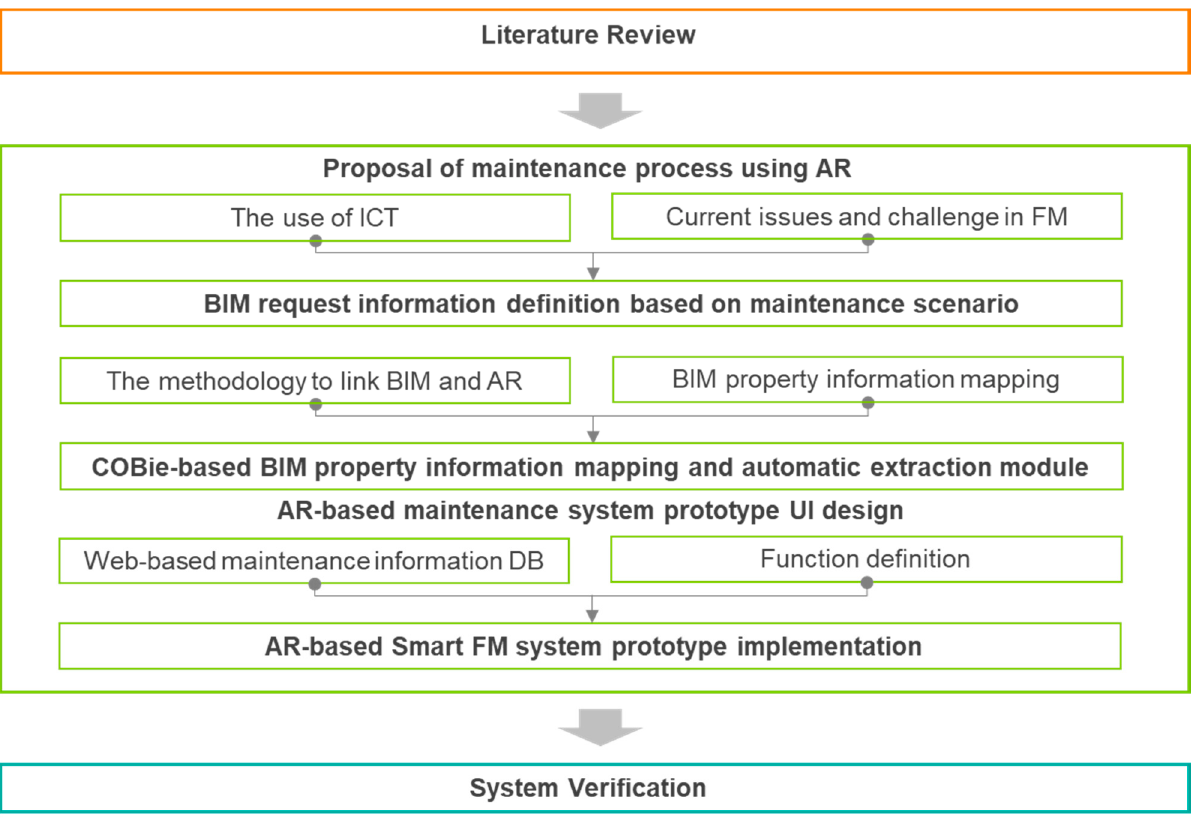
Figure 1. Research content and procedure.